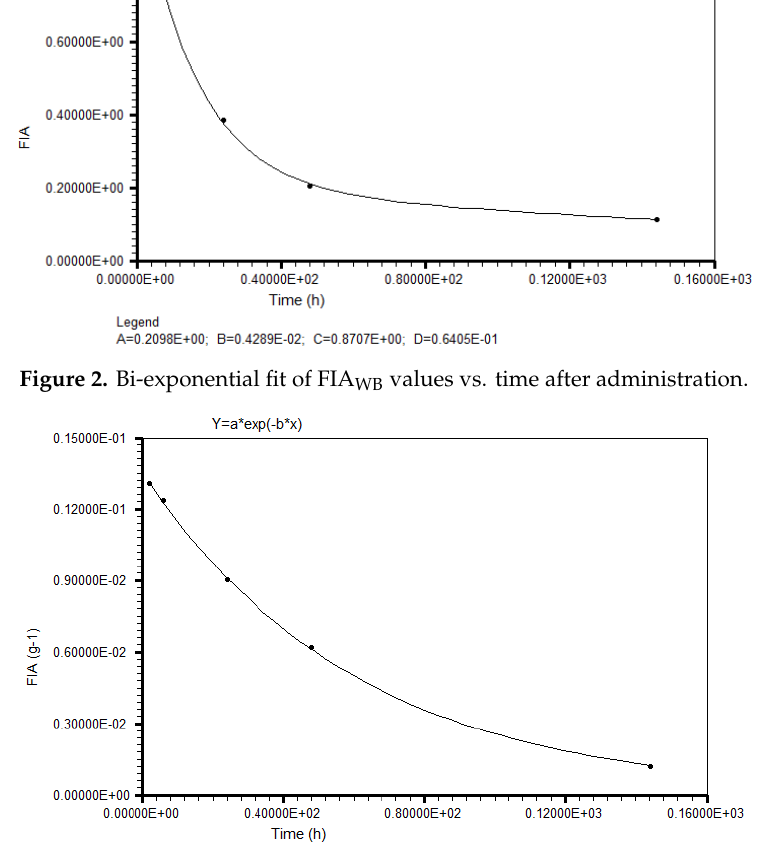
Table 3. WB and BL retention time, dose to BL, and red marrow (RM) calculated, respectively, from the European Association of Nuclear Medicine (EAMN), the Italian Association of Medical Physics (AIFM), and Traino methods.